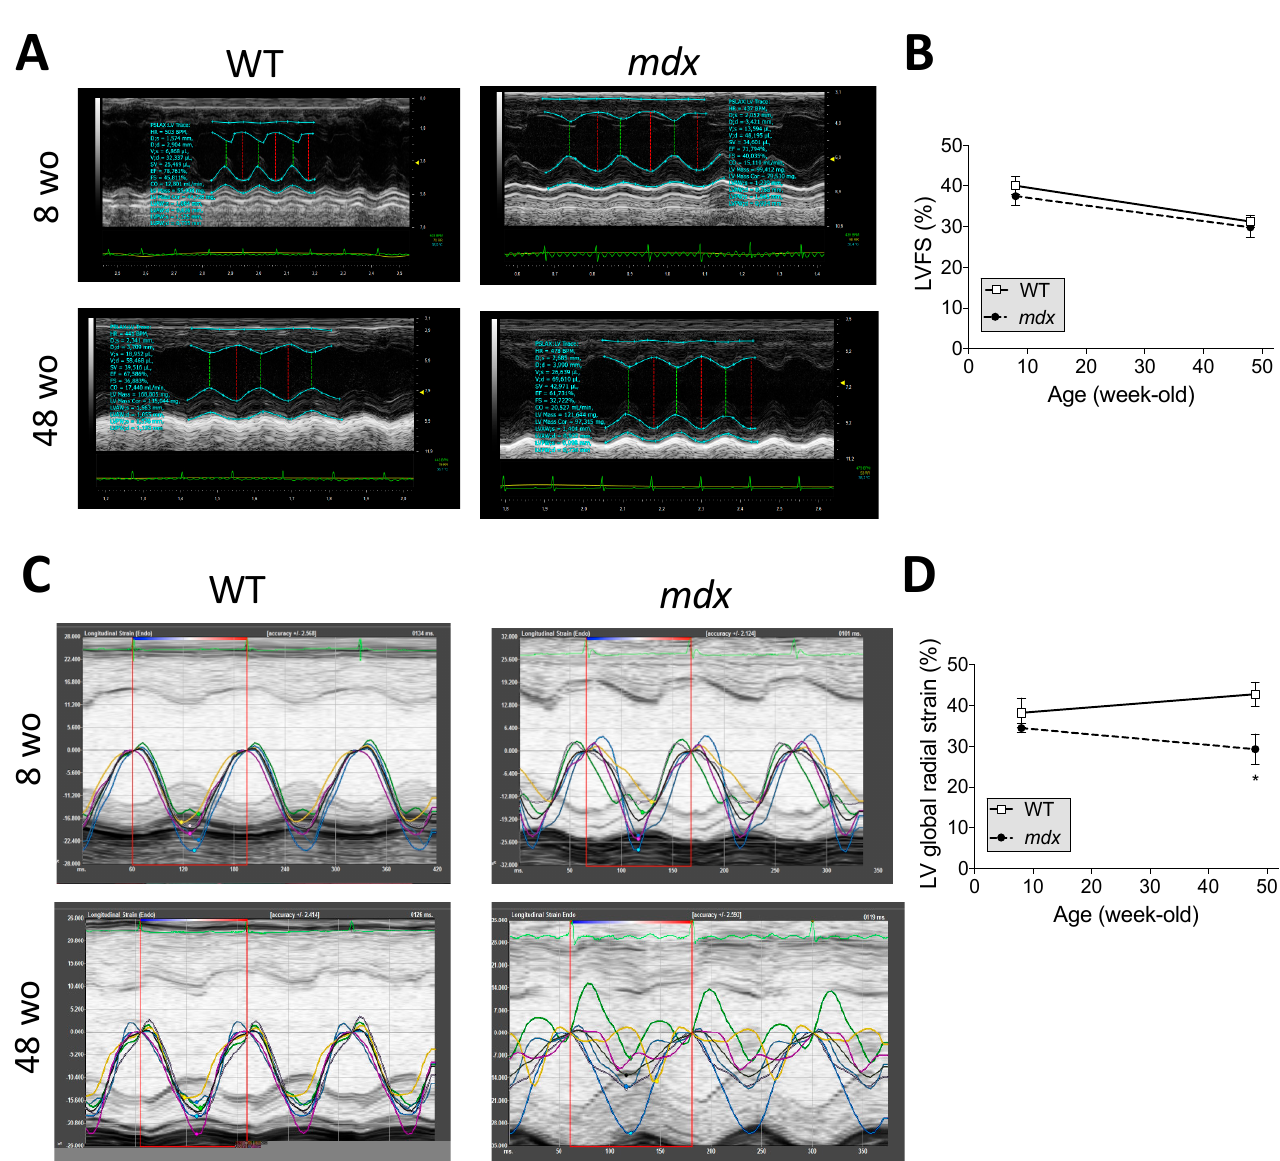
Figure 5. LV global strains are altered before LV ejection fraction in mdx mice. ( A ) M-mode images in WT and mdx at 8 and 48 wo. ( B ) Percentage (%) of the left ventricular fractional shortening (LVFS) in WT and mdx mice from 8 to 48 wo. ( C ) High-frequency ultrasound-based two-dimensional speckle-tracking (STE) images in WT and mdx at 8 and 48 wo. ( D ) Percentage (%) of the left ventricular (LV) global radial global strain in WT and mdx mice from 8 to 48 wo. Data are shown as mean ± SEM ( n = 10 animals/group). A two-way ANOVA test was performed. * p < 0.05, mdx vs. WT mice at the same age.